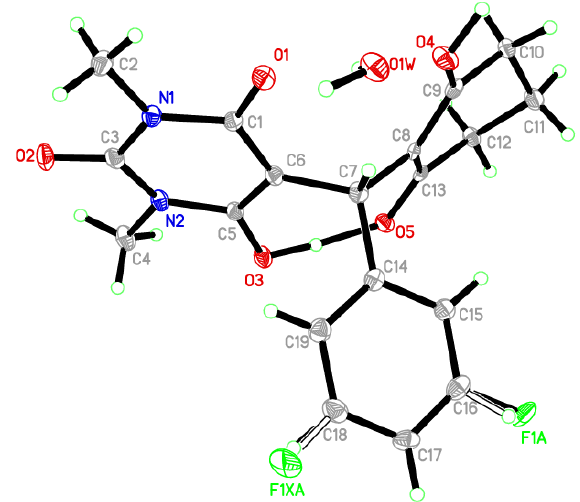
Figure 1. The molecular structure of the target compound showing 40% probability displacement ellipsoids for non-H atoms.